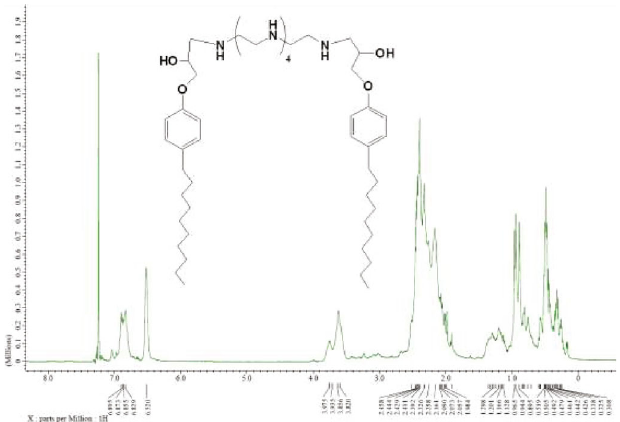
Figure 1: 1 H-NMR spectra of NTEPA.